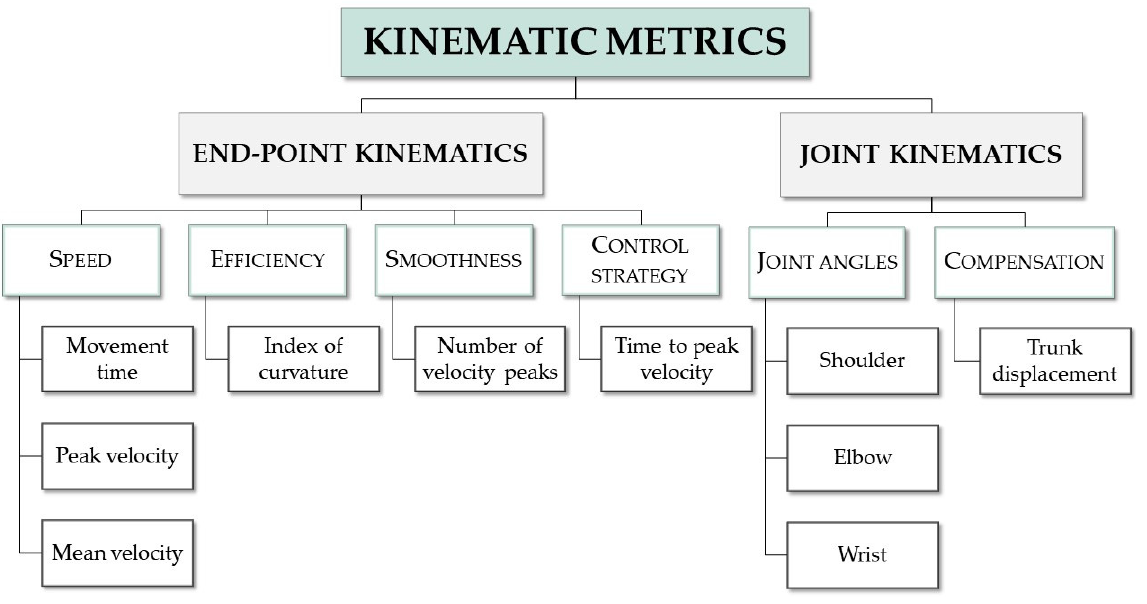
Figure 5. Summary of kinematics measures that should be considered to assess the influence of multifield FES in UL movement quality.